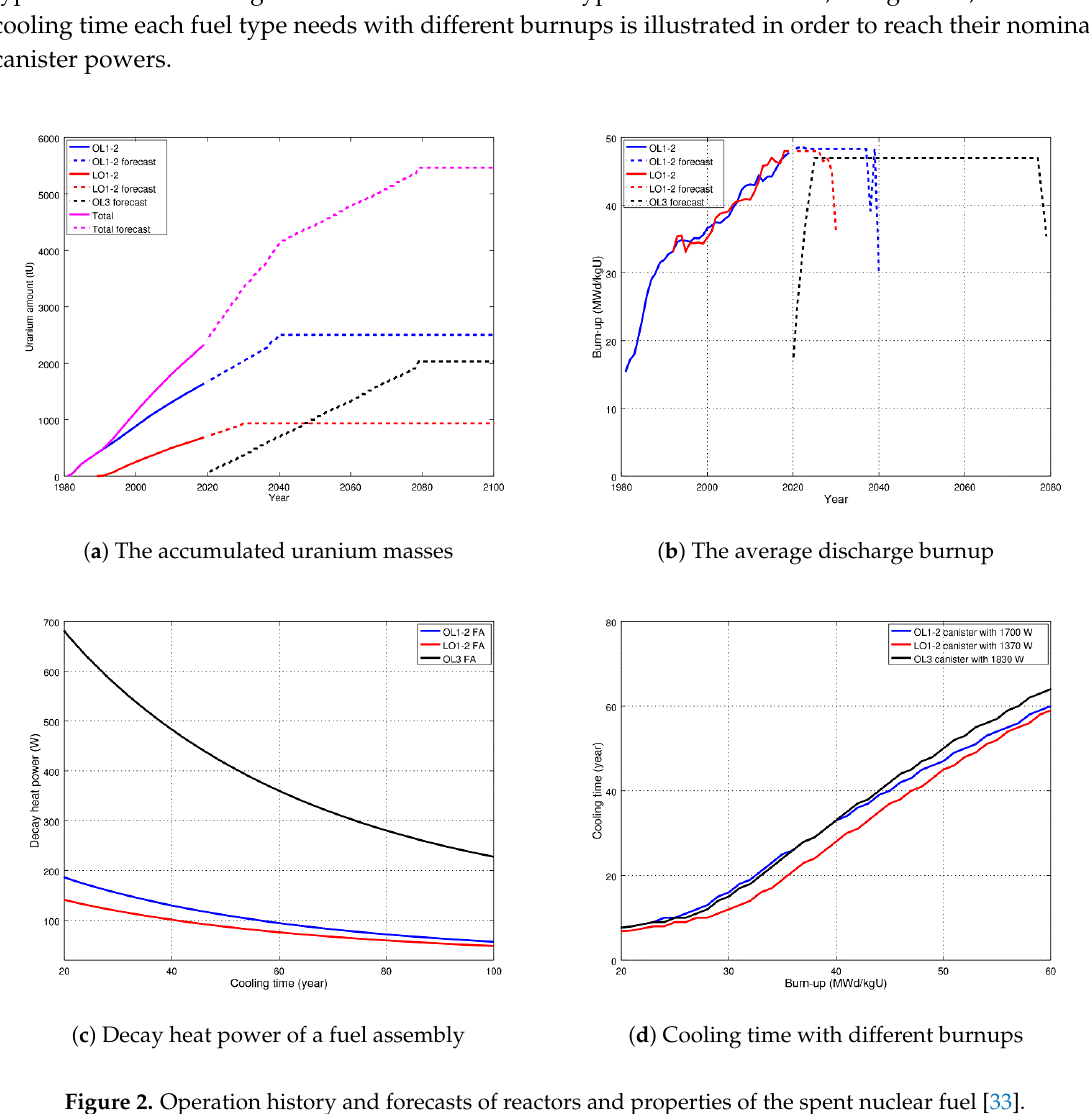
Figure 2. Operation history and forecasts of reactors and properties of the spent nuclear fuel